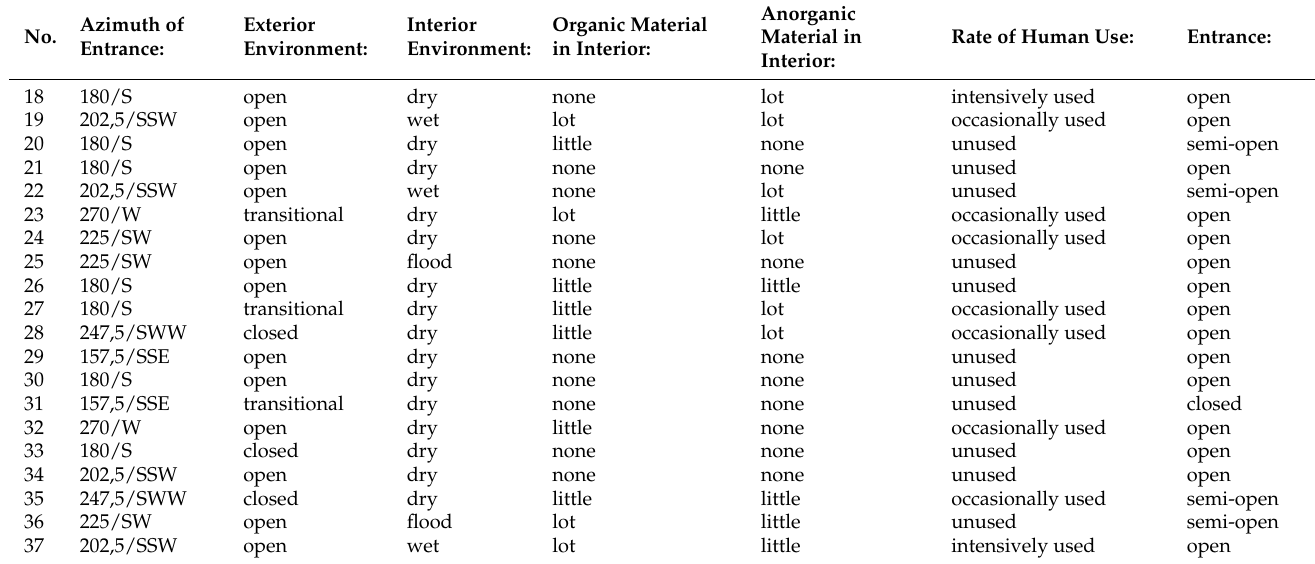
Table A4. Table of SA-CEFs study objects with data that were obtained by field survey (2014-2021). The numbering of the individual SA-CEFs corresponds to the data in Table 1—part 2.